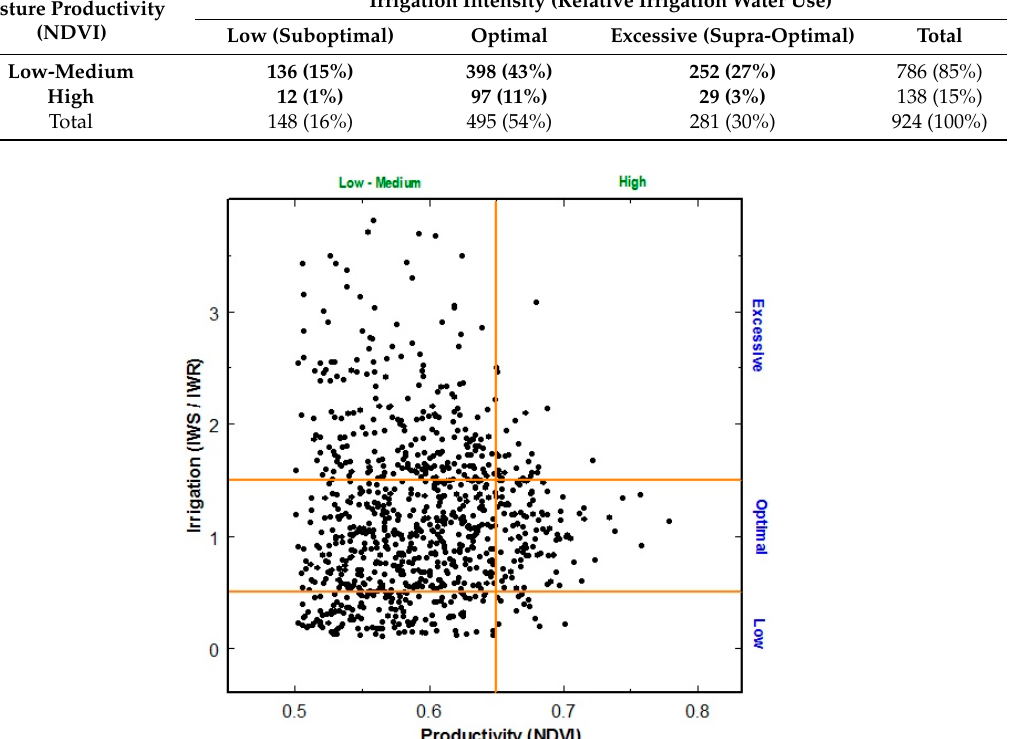
Table 2. Summary of the distribution of dairy farms according to the categories of total irrigation water productivity (TIWP) in the Goulburn-Murray Irrigation Region. Pasture Productivity (NDVI)